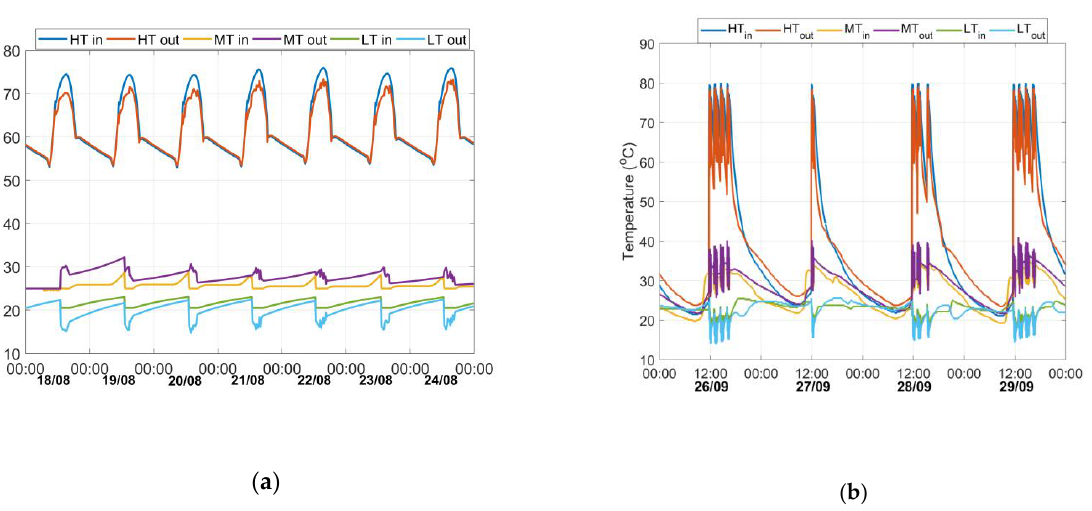
Figure 9. Temperature of secondary chiller’s streams on ( a ) hot summer days and ( b ) cloudy days.